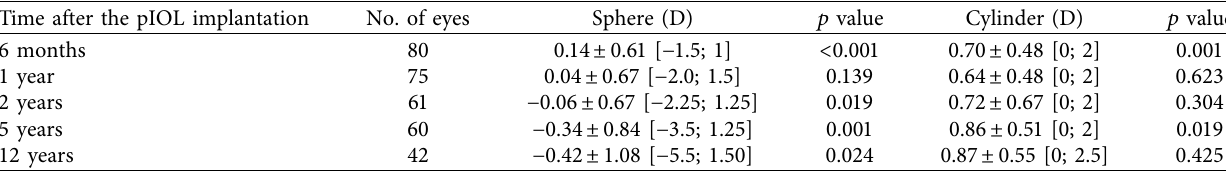
Table 2: Refractive results.